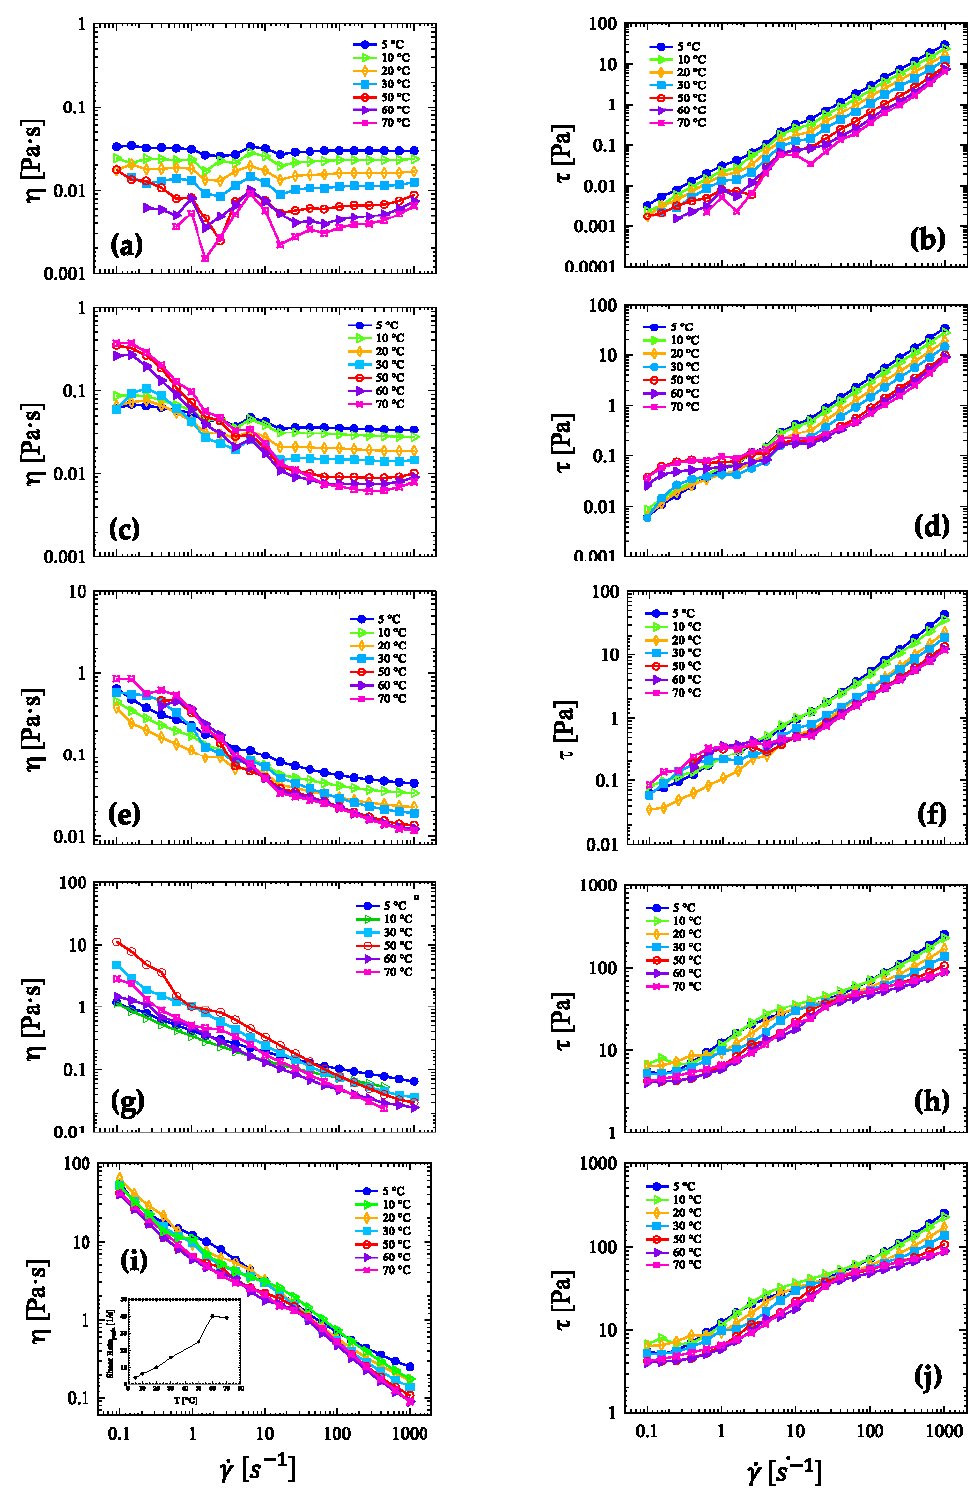
Figure 3. Flow curves in terms of shear viscosity and shear stress of HRCM-based suspensions with: ( a , b ) 0.08, ( c , d ) 0.16, ( e , f ) 0.40, ( g , h ) 0.80, and ( i , j ) 2.40 wt% HRCM load. Data were collected at constant temperature ranging from 5 to 70 ◦ C via log ramp sampling rate. Inset in ( i ): Shear rate at the observed shear viscosity peak as a function of